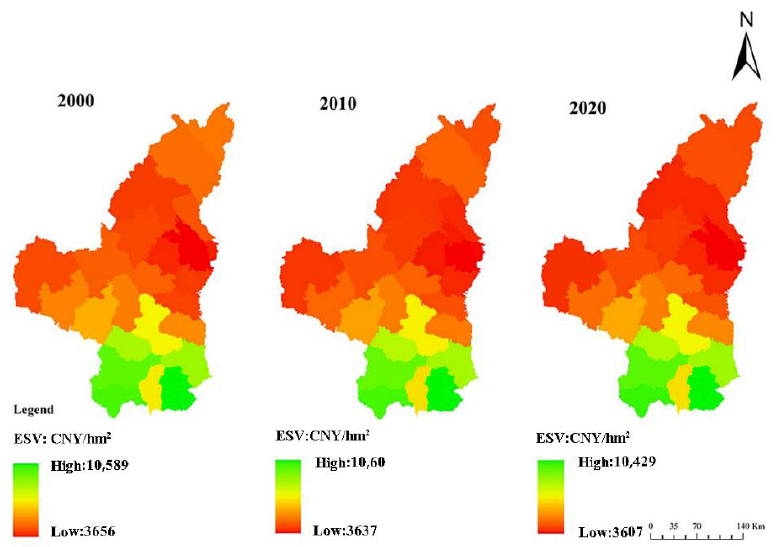
Figure 4. Distribution of the ESV by districts and counties in the Loess Plateau of Northern Shaanxi.